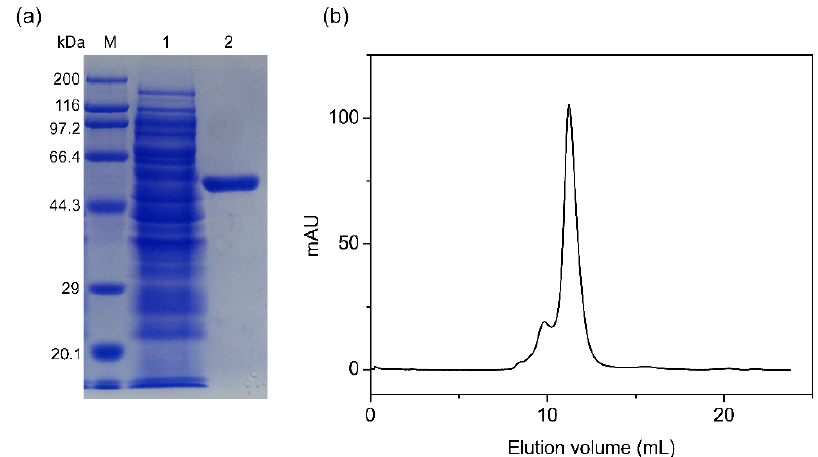
Figure 4. Molecular weight of Pp Abf51b determined by ( a ) SDS-PAGE and ( b ) gel filtration chromatography. ( a ) SDS-PAGE analysis (M), protein molecular weight markers (TaKaRa, code number 3597Q) (1), supernatant of cell lysis from recombinant Escherichia coli BL21 (DE3) cells harboring pET-28a-ppabf51b plasmid, 2, recombinant Pp Abf51b purified from Ni-NTA agarose column; ( b ) Gel filtration chromatography analysis of purified Pp Abf51b by Superdex 200 10/300 GL column.